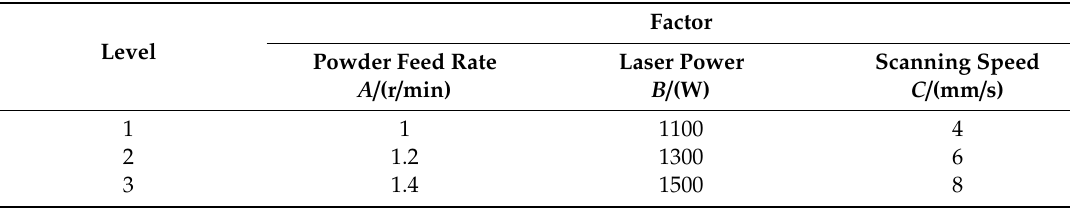
Table 3. Level and factor design of orthogonal